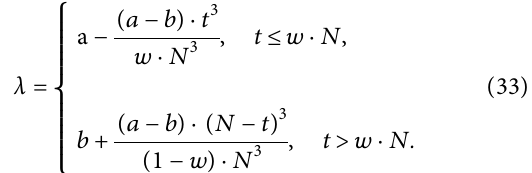
Figure 2: The changing curves of λ